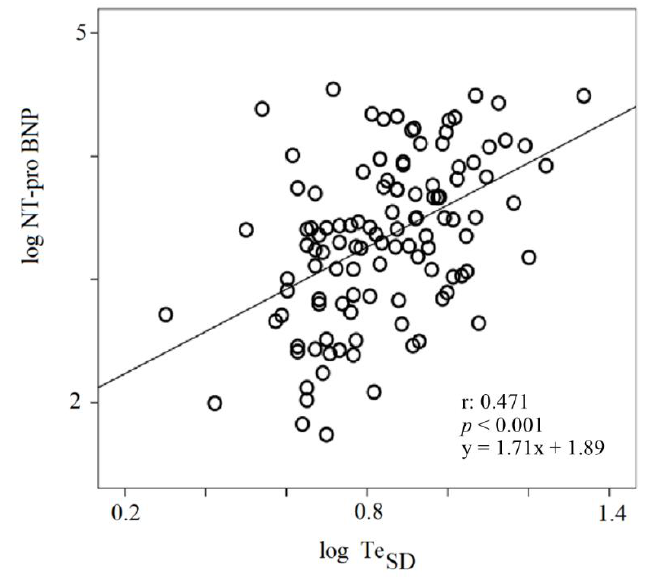
Figure 1. Linear regression between log Te SD and NT-proBNP. NT-proBNP: N-terminal Pro Brain Natriuretic Peptide; SD: standard deviation.